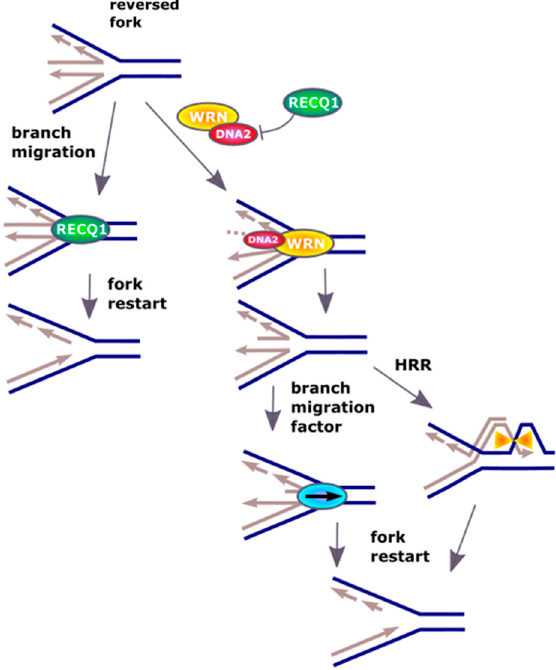
Figure 3. DNA2 restarts reversed replication fork. Excessive unwinding of the template in DNA replication, resulting from escape of DNA helicase from DNA polymerase or DNA damage in the template, leads to regression of replication fork by pairing of the newly synthesized strands. Resulted “chicken foot” structure is primarily resolved by the RECQ1 helicase, but if its activity is inhibited or in RECQ1-deficient cells, DNA2 can cleave the single-strand 5 ′ end of the regressed fork assisted by ATP-ase activity of WRN (Werner syndrome ATP-dependent helicase) or BLM (Bloom syndrome protein) (not presented). The restart is preceded by the action of branch migration factors, not displayed in that scheme. Recombination mechanisms based on homology (HRR) are an alternative for RECQ1 and DNA2 action.